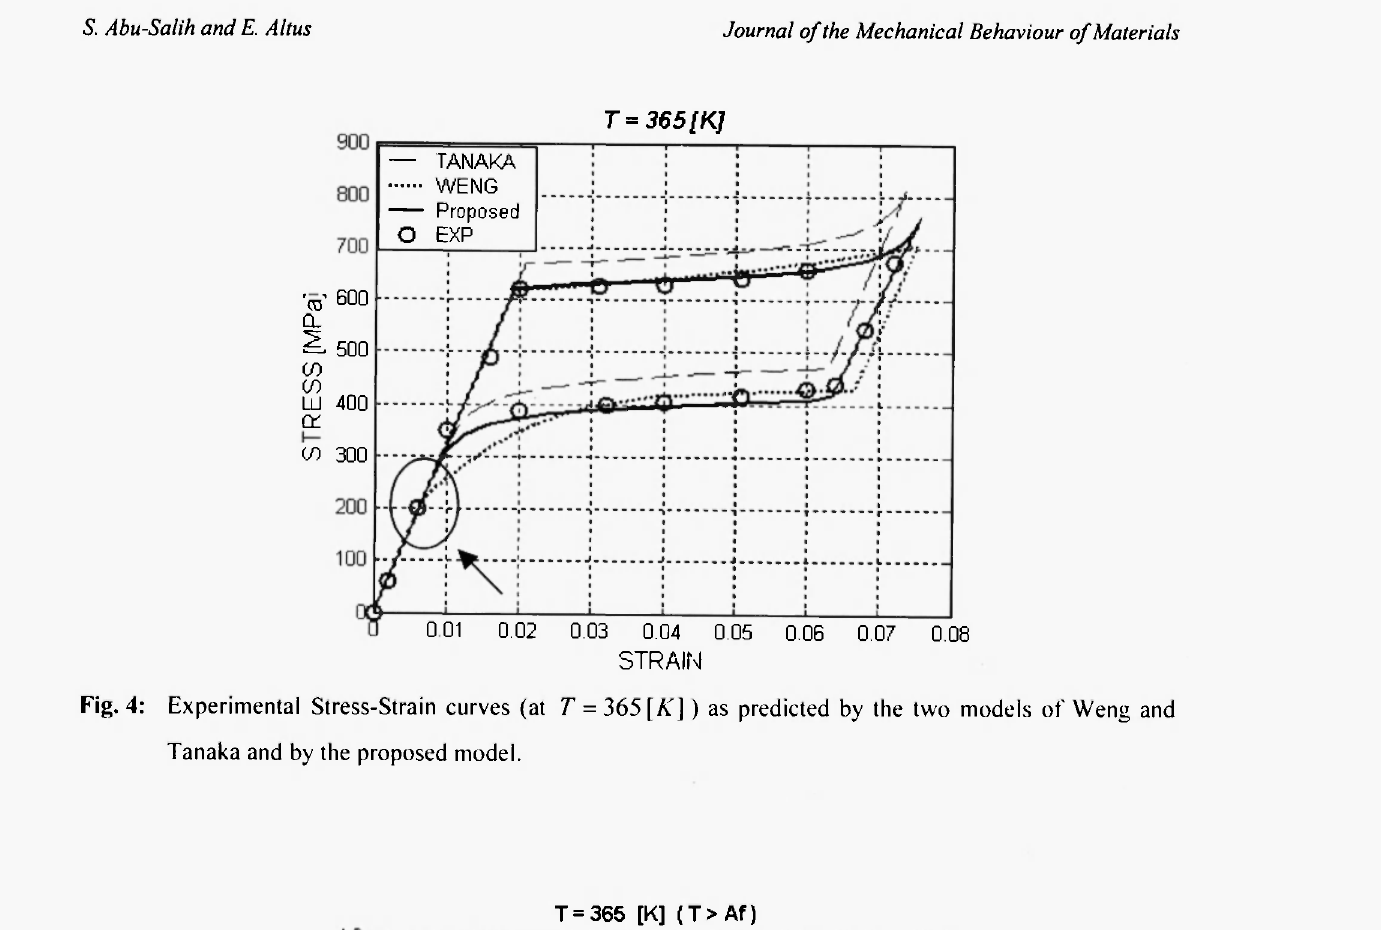
Fig. 4: Experimental Stress-Strain curves (at Τ = 365 [A']) as predicted by the two models of Weng and Tanaka and by the proposed model.